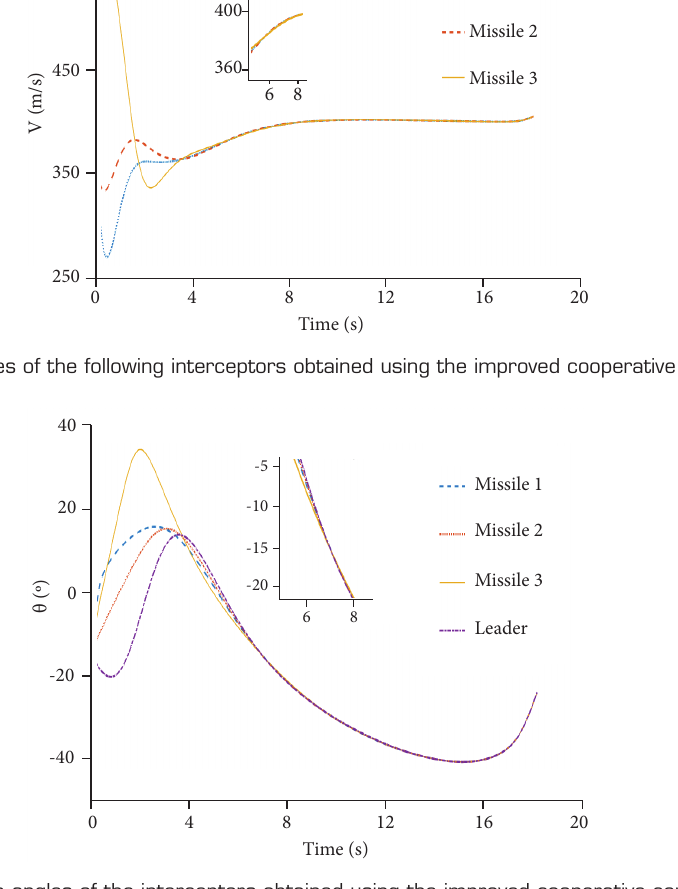
Figure 5. Flight path angles of the interceptors obtained using the improved cooperative control